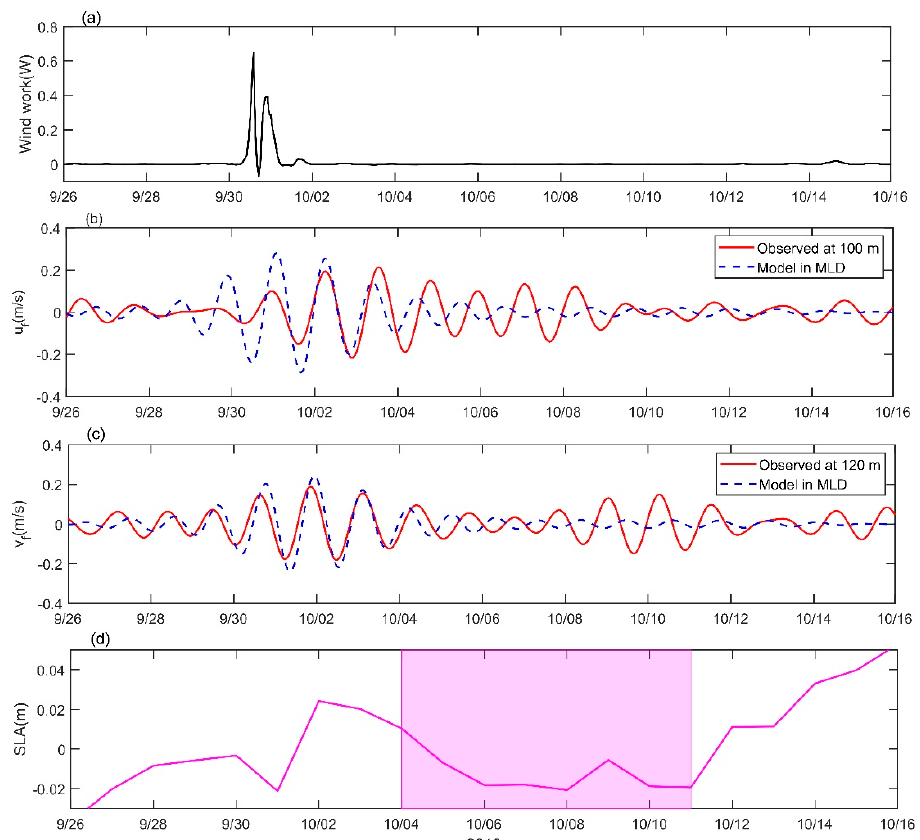
Figure 15. ( a ) The time series of the wind work computed from the slab model. ( b ) Comparison of the zonal near-inertial currents of observation (solid red line) below the mixed layer and simulation (dashed blue line) in the mixed layer, with ( c ) the same as ( b ), but for the meridional near-inertial currents. ( d ) The time evolution of the sea level anomalies at the mooring, and the purple shading indicates the period when the cyclonic eddy affected the mooring.